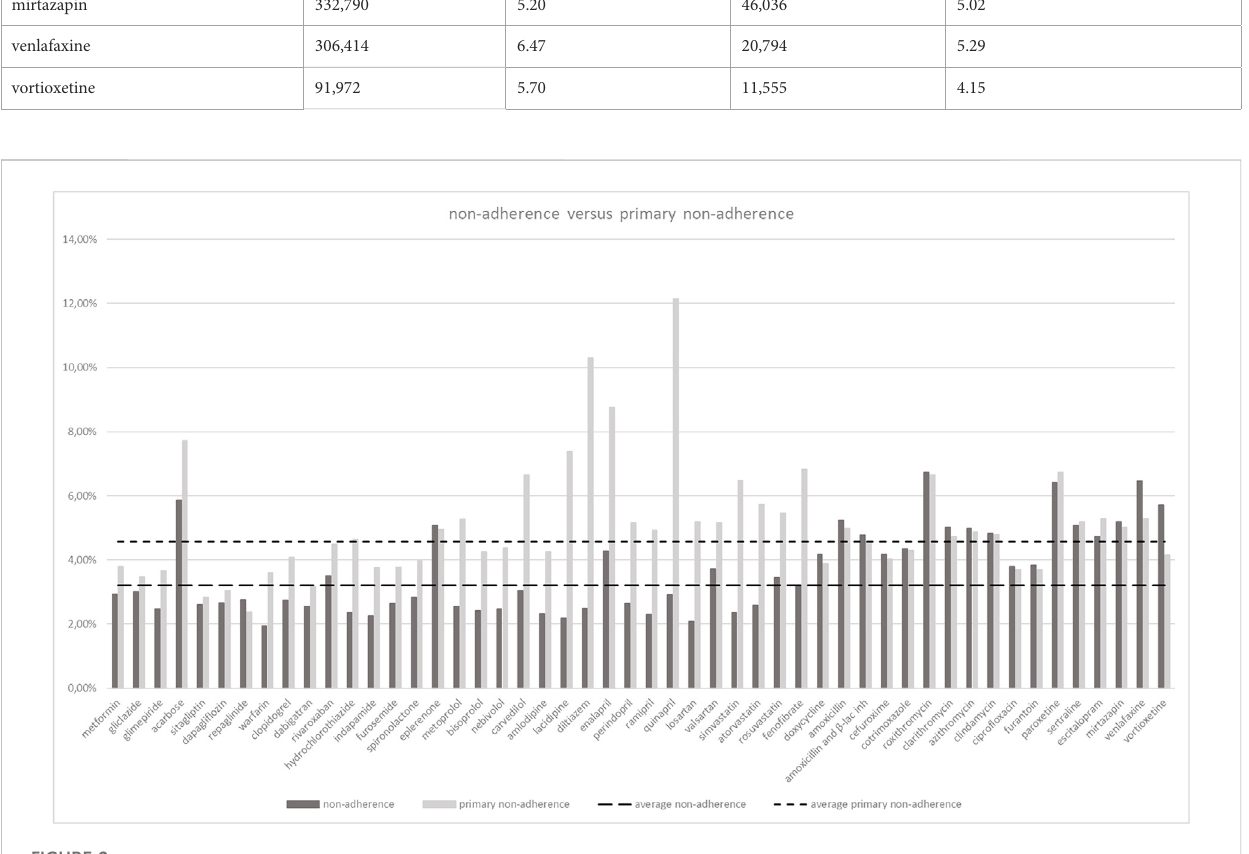
FIGURE 2 Non-adherence versus primary non-adherence by